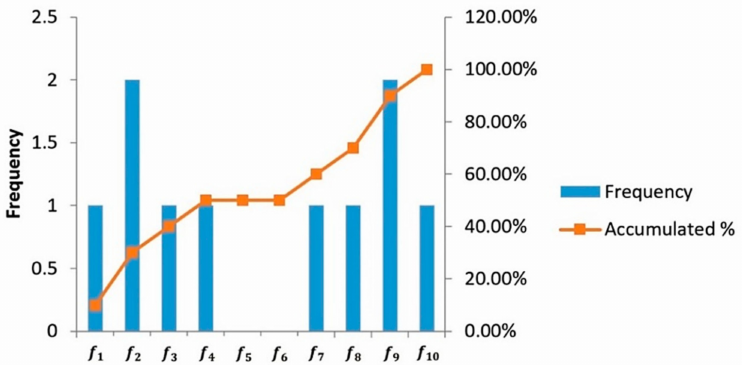
Figure 21. The last population histogram.